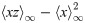
Correlated occupancy, release and post-synaptic voltage statistics when there are multiple contacts per presynaptic cell.(A) Illustration of a case with one presynaptic cell N = 1 making three contacts n = 3. Shown in descending order: presynaptic spike train (α = 0.4, r = 5Hz), occupancy of the three release sites (restock λ = 2Hz), the corresponding release-event time courses (p = 0.6), and the voltage time course (see Table 1 for parameters). (B) The occupancy correlation 〈xz〉∞ for a pair of sites receiving the same presynaptic spike train and the covariance 〈xz〉∞-〈x〉∞2 (see Eqs 34 and 35). (C) The cross-covariance of release events from a pair of sites sharing the same presynaptic cell (Eq 39). (D) Post-synaptic voltage standard deviation (top: from Eq 42) and CV (bottom) as a function of α for four combinations of N, n as marked. With each of these choices, where Nn = 1000, the mean voltage (Eq 32) is the same as in Fig 2D. The code used to generate this figure is provided in the Supporting Material.